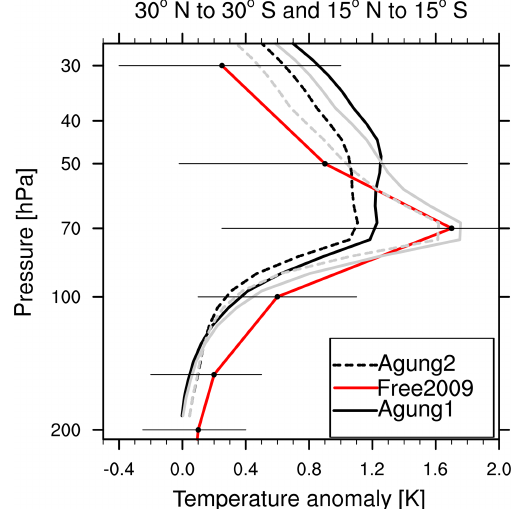
Figure 8. Profiles of temperature anomaly (K) for the model data and RATPAC radiosonde measurements taken from Free and Lan- zante (2009), averaged over 2 years after the Agung eruption(s). Model results are averaged over 30 ◦ N to 30 ◦ S (black) and 15 ◦ N to 15 ◦ S (gray), whereas radiosonde data are averaged for the trop- ics only (30 ◦ N to 30 ◦ S; red line). The horizontal lines mark the 95% confidence interval for the RATPAC radiosonde